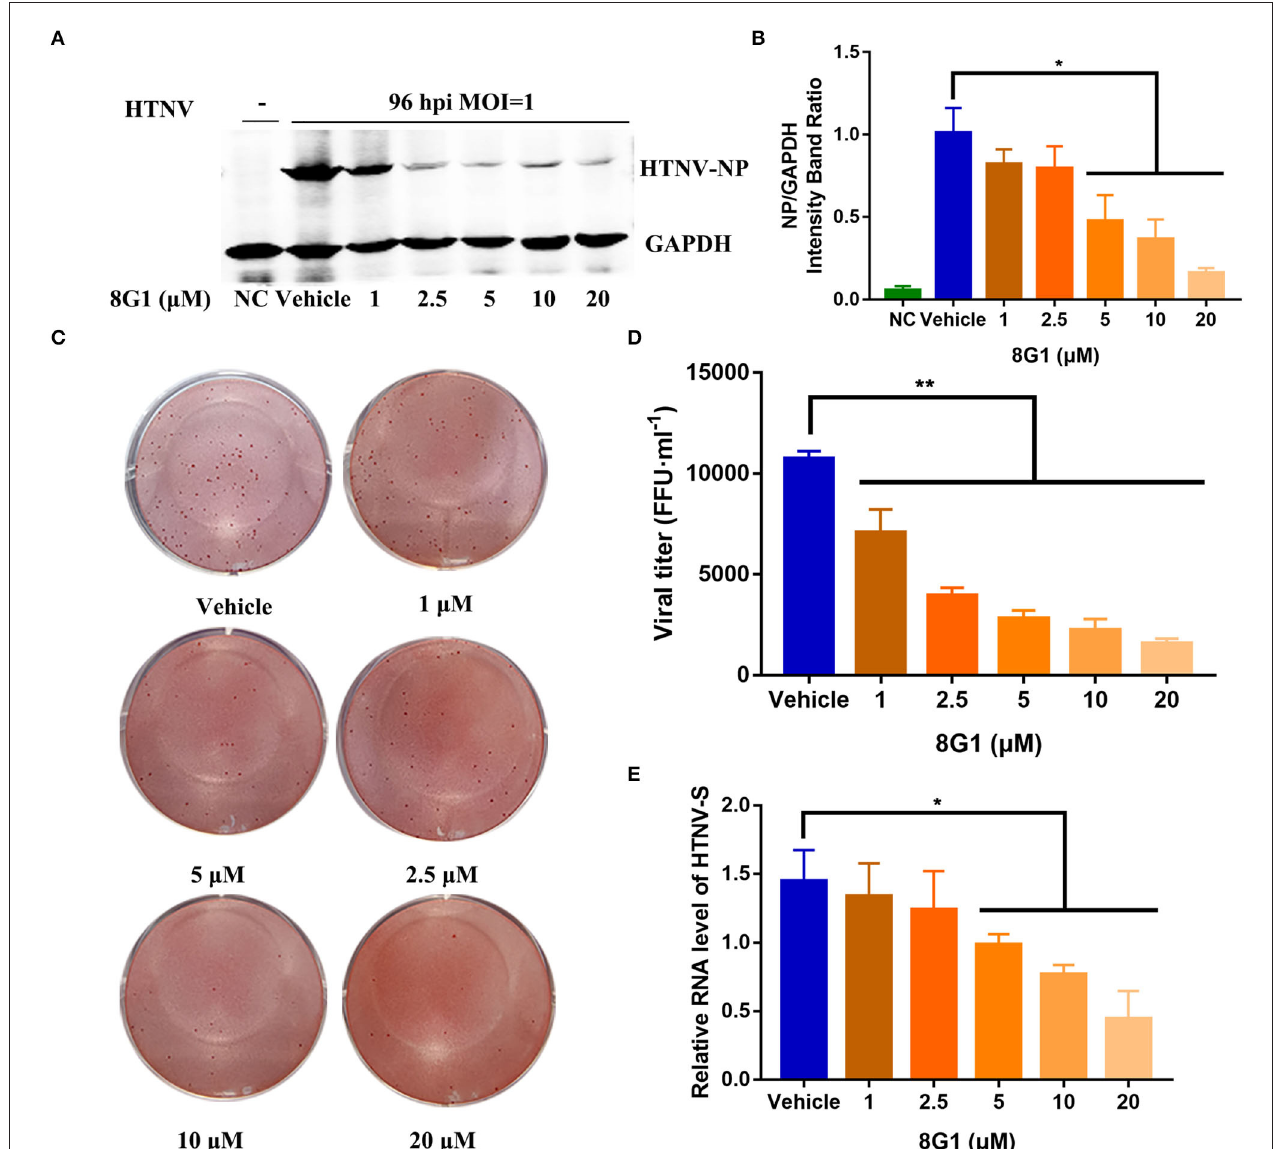
FIGURE 4 | Compound 8G1 inhibited HTNV replication in A549 cell post-infection. (A) The representative Western blot staining for HTNV NP protein in the negative control (NC) group, Vehicle-treated control group, and compound 8G1 (1, 2.5, 5, 10, and 20 µ M) treatment groups. (B) The analyzed result of expression of HTNV nucleocapsid protein in the NC, Vehicle, and compound 8G1 treatment groups in A549 cells post-HTNV infection, p < 0.05 vs. Vehicle, n = 3. (C) The representative imaging for the focus-forming unit of HTNV in the Vehicle group and compound 8G1 (1, 2.5, 5, 10, and 20 µ M) treatment groups. (D) The viral titer of HTNV was analyzed in the Vehicle group and compound 8G1 treatment groups. ** p < 0.01 vs. Vehicle, n = 3. (E) The expression of HTNV-S gene in the Vehicle group and compound 8G1 (1, 2.5, 5, 10, and 20 µ M) groups, * p < 0.05 vs. Vehicle, n =